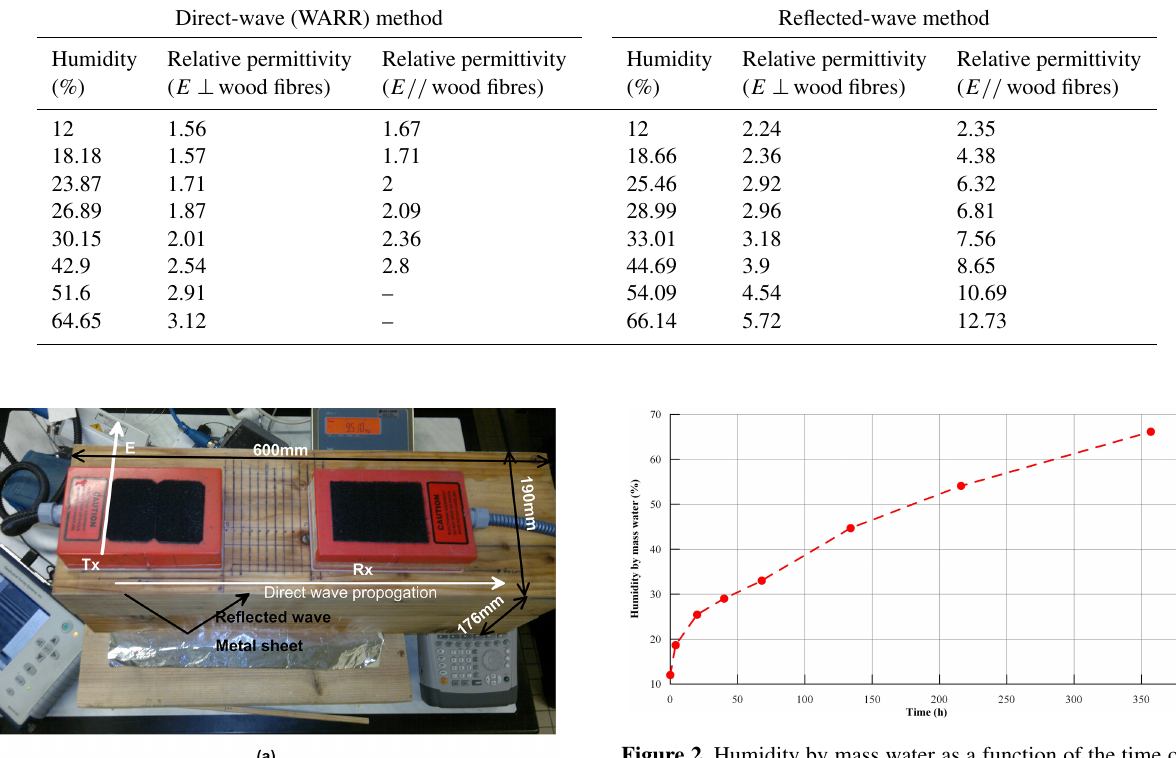
Figure 2. Humidity by mass water as a function of the time of im- mersion into the